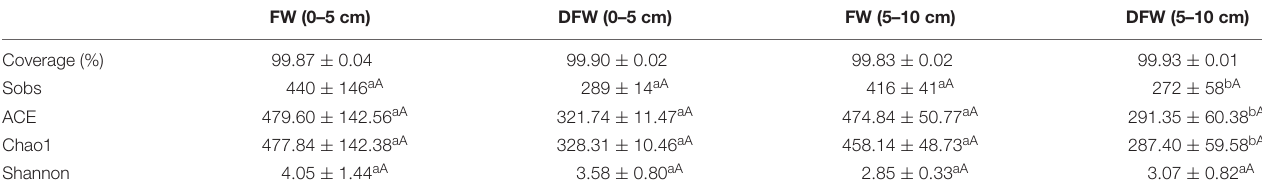
TABLE 2 | The α diversity indices of fugal community in FW and DFW.